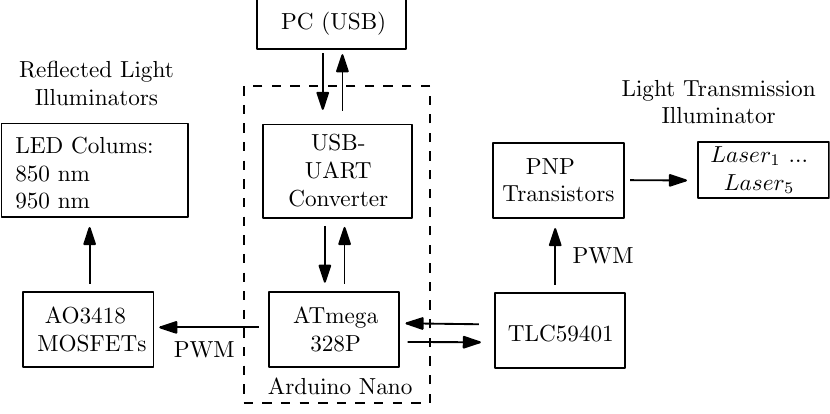
Figure 5. Schematic structure of the illumination control